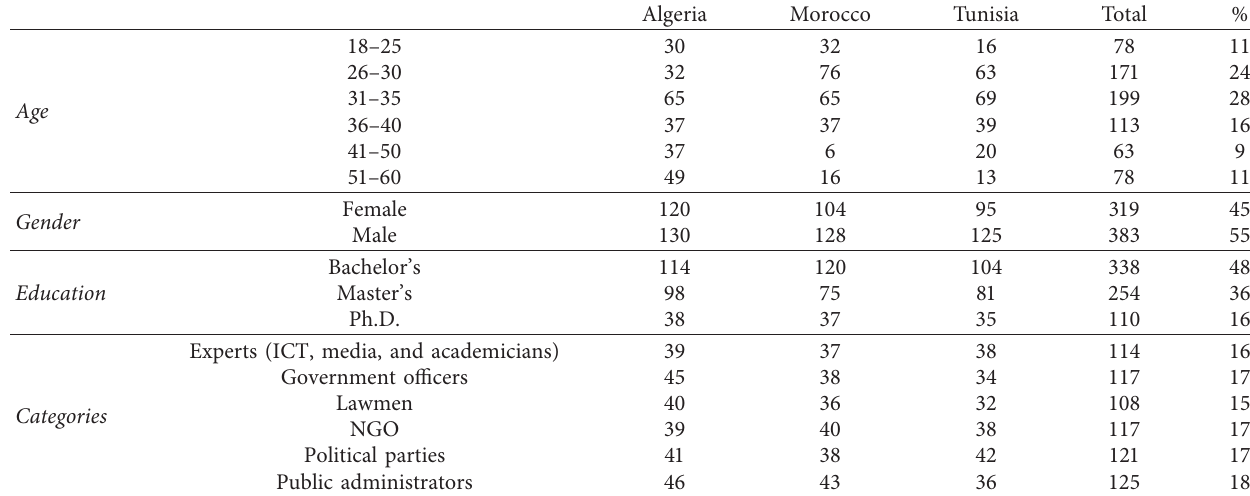
Table 2: Demographic characteristics of the research sample.